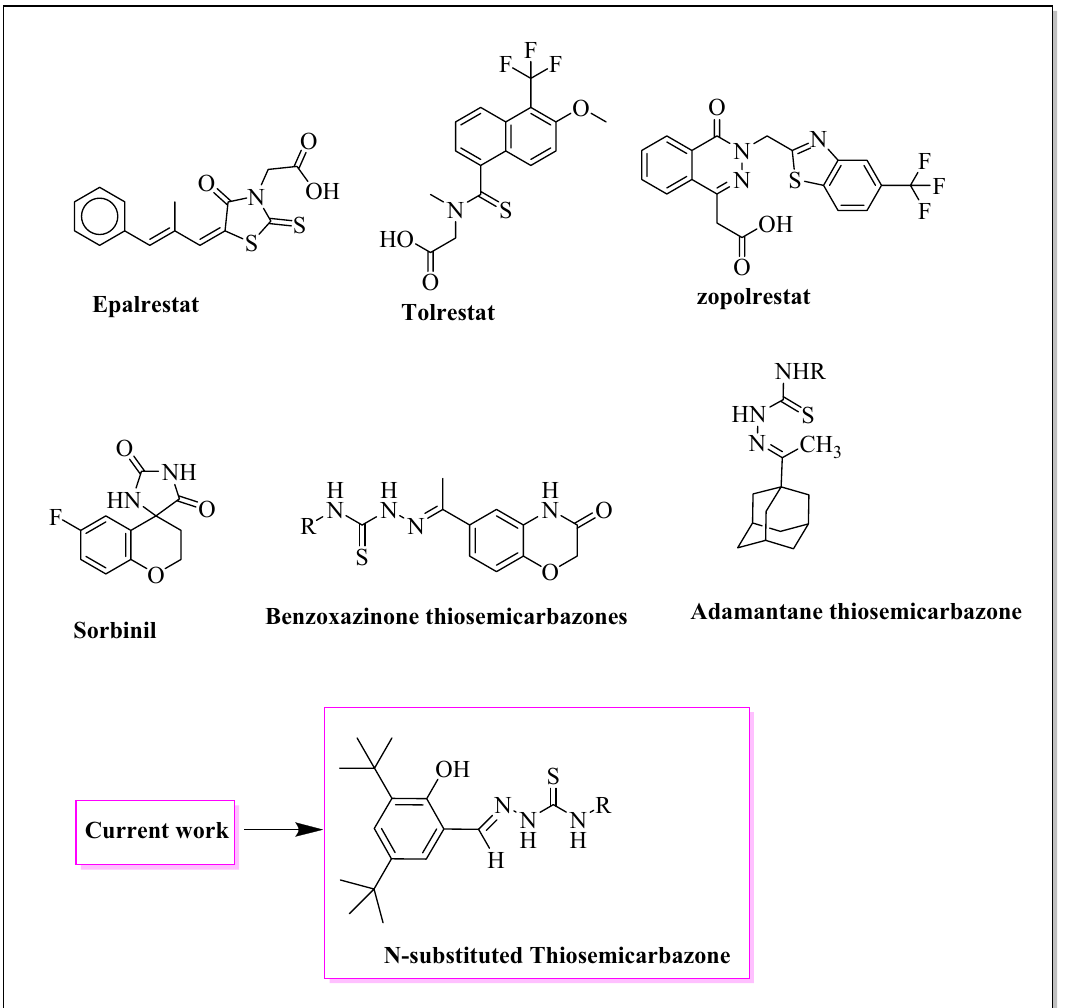
Figure 2. Some reported aldose reductase inhibitors and the N-substituted thiosemicarbazones reported